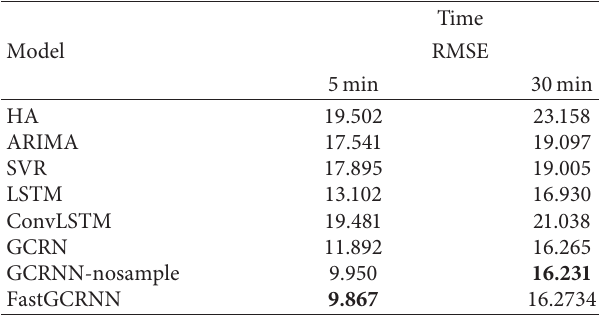
Table 2: Comparison of results between FastGCRNN model and other traffic flow prediction